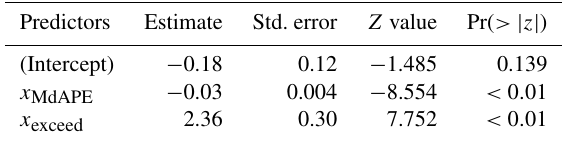
Figure 6. Potential benefits realized by realistic forecast ( I ) pre- dicted using linear regression with predictors x exceed and the me- dian absolute percentage error ( x MdAPE ). Red corresponds to nega- tive values of I , meaning that the performance of realistic forecasts is worse than the one attained by control rules. Blue corresponds to positive values of I , meaning that realistic forecasts outperform control rules. Each point corresponds to one of the 269 dams with I PF > 4 . 7%. The corresponding color represents the value of I at- tained via simulation with the reservoir operation model. Dams with accurate forecasts and high values of x exceed (inflow frequently ex- ceeds maximum turbine release) tend to have greater hydropower benefits realized from realistic forecasts. Table 2. Coefficients of linear regression to predict I